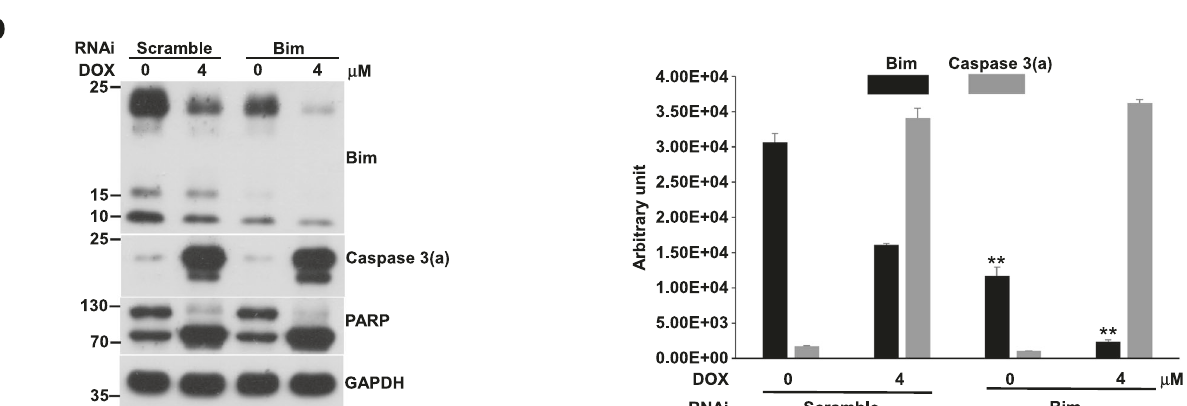
Cell Death Discovery (2021)